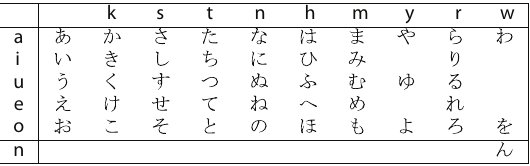
Figure 2: 50-sound table of KANA.